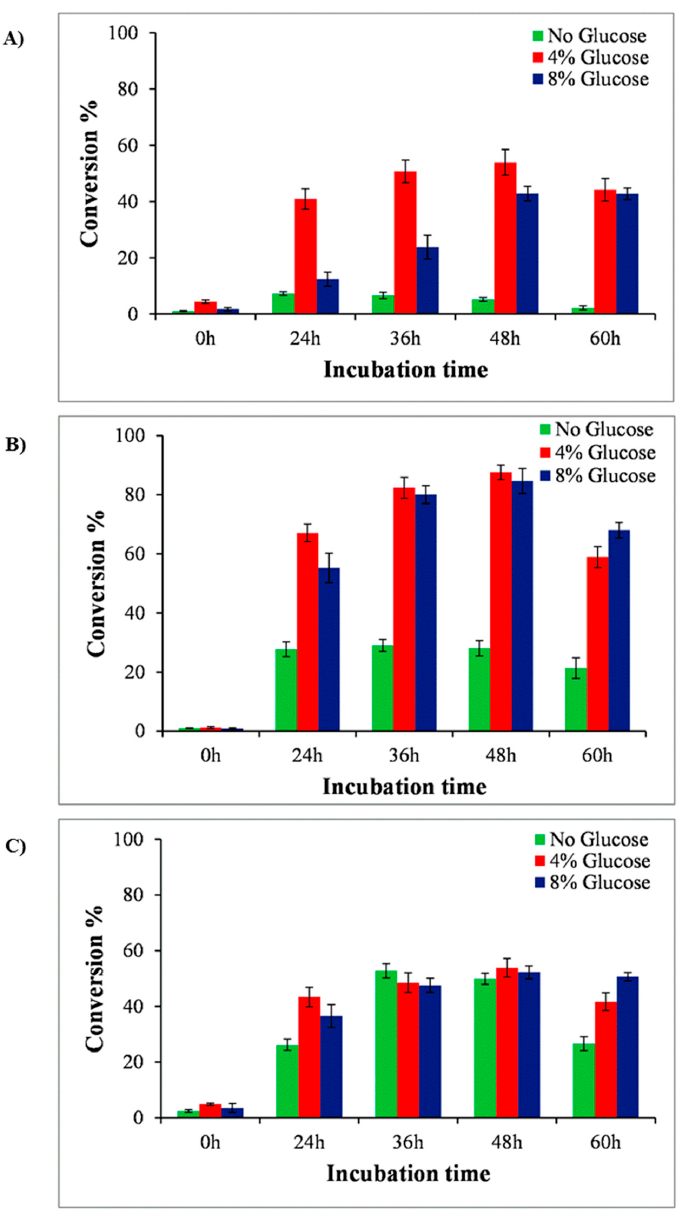
Figure 4. Production profile of anthraquinone- O -glucoside at different incubation time intervals and glucose supplementations. ( A ) Alizarin, ( B ) anthraflavic acid, and ( C ) 2-amino-3- hydroxyanthraquinone.